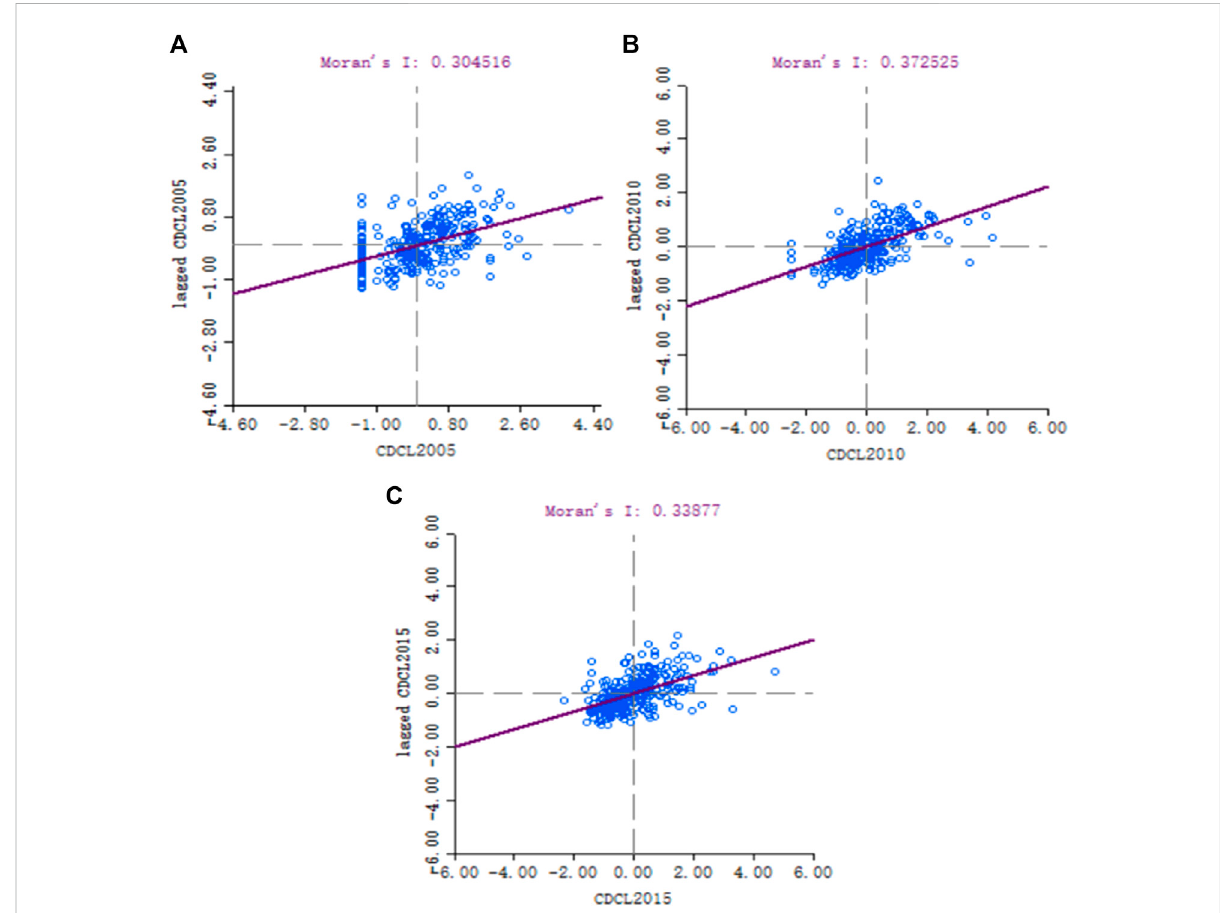
Moran scatter plot of the coupling coordination; (A) for 2005, (B) for 2010, (C) for